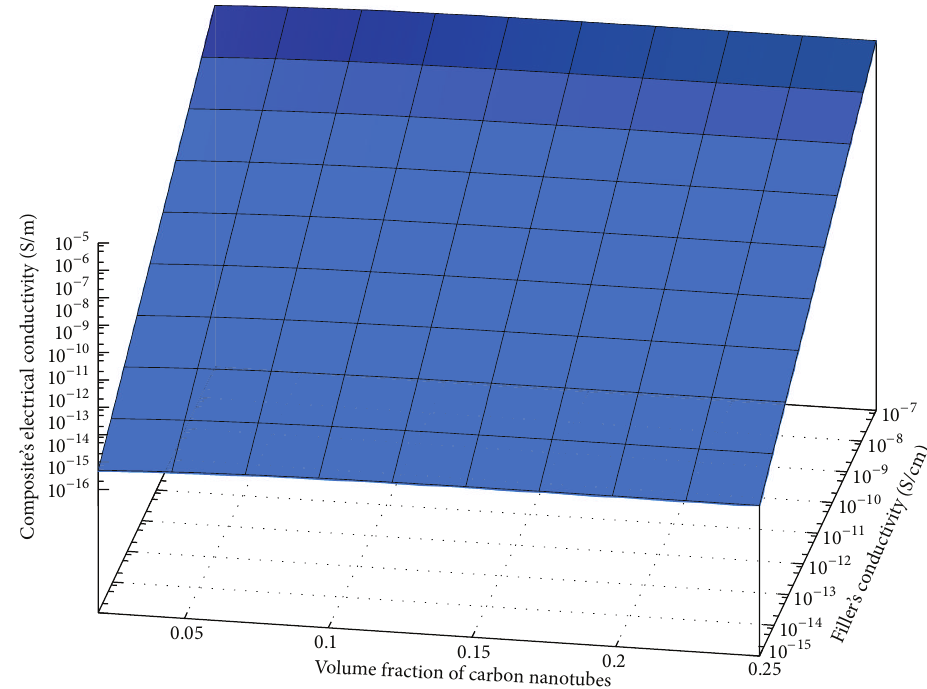
Figure 26: DC electrical conductivity of the nanocomposite when both the conductivity of the filler and the volume fraction of the filler are varied (Sigmoidal function